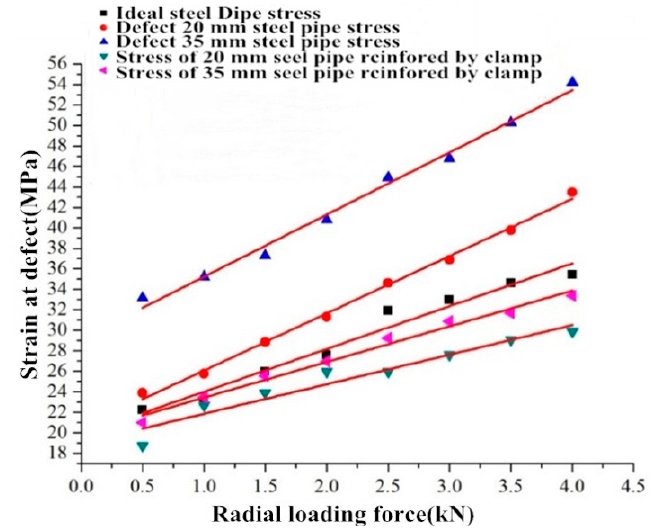
Figure 19. Strain at a radial load measurement point.